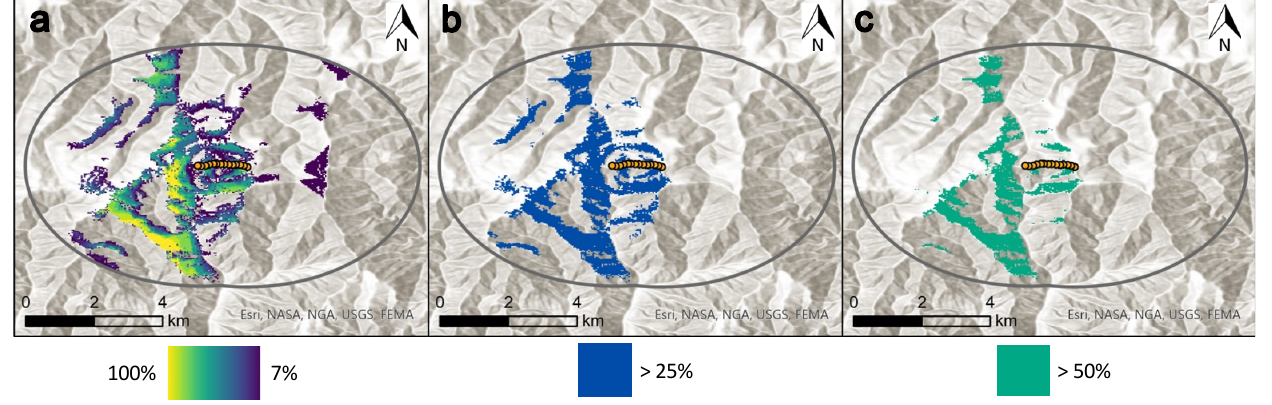
Figure 6. Example viewshed outputs, calculated using a 30 m LANDFIRE-derived DSM, for the 2021-07-22 handline. Gray boundary represents viewshed radius. ( a ) V c , indicating areas visible to any node, with shading indicating the percent of nodes visible to each pixel. ( b ) V c ,0.25 , indicating areas visible to at least 25% of nodes. ( c ) V c ,0.5 , indicating areas visible to at least 50% of nodes.